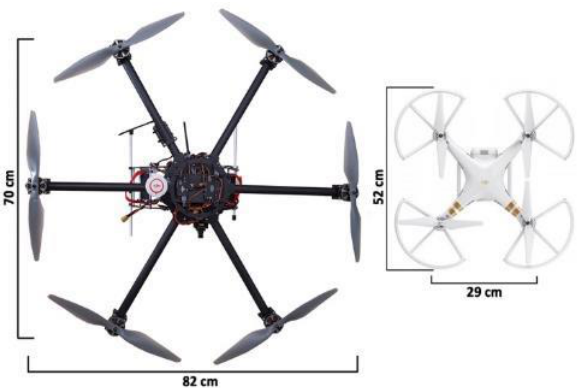
Figure 2: Hexacopter and DJI Phantom 3 Professional